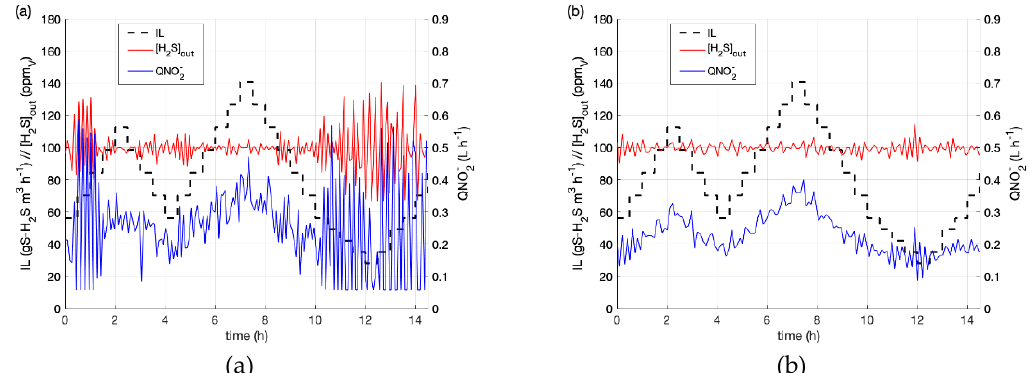
Figure 3. Staircase perturbation for PID ( a ) and PI ( b ) adjusted by MO. Blue lines: nitrite flowrate, red lines: H 2 S out , dashed black lines H 2 S IL.